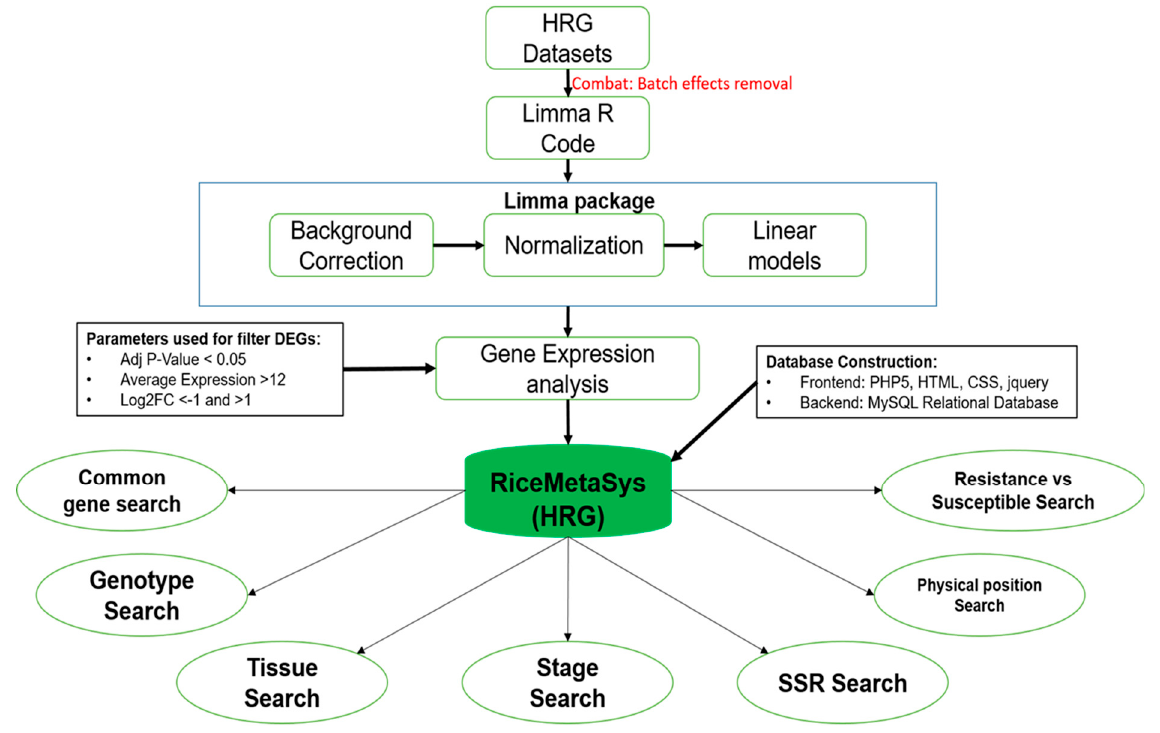
Figure 2. Schematic representation of data analysis and construction of the RiceMetaSys-H database. It shows the meta-analysis pipeline followed for microarray data analysis and the search provisions enabled in the database. The tools used and the statistical parameters are also